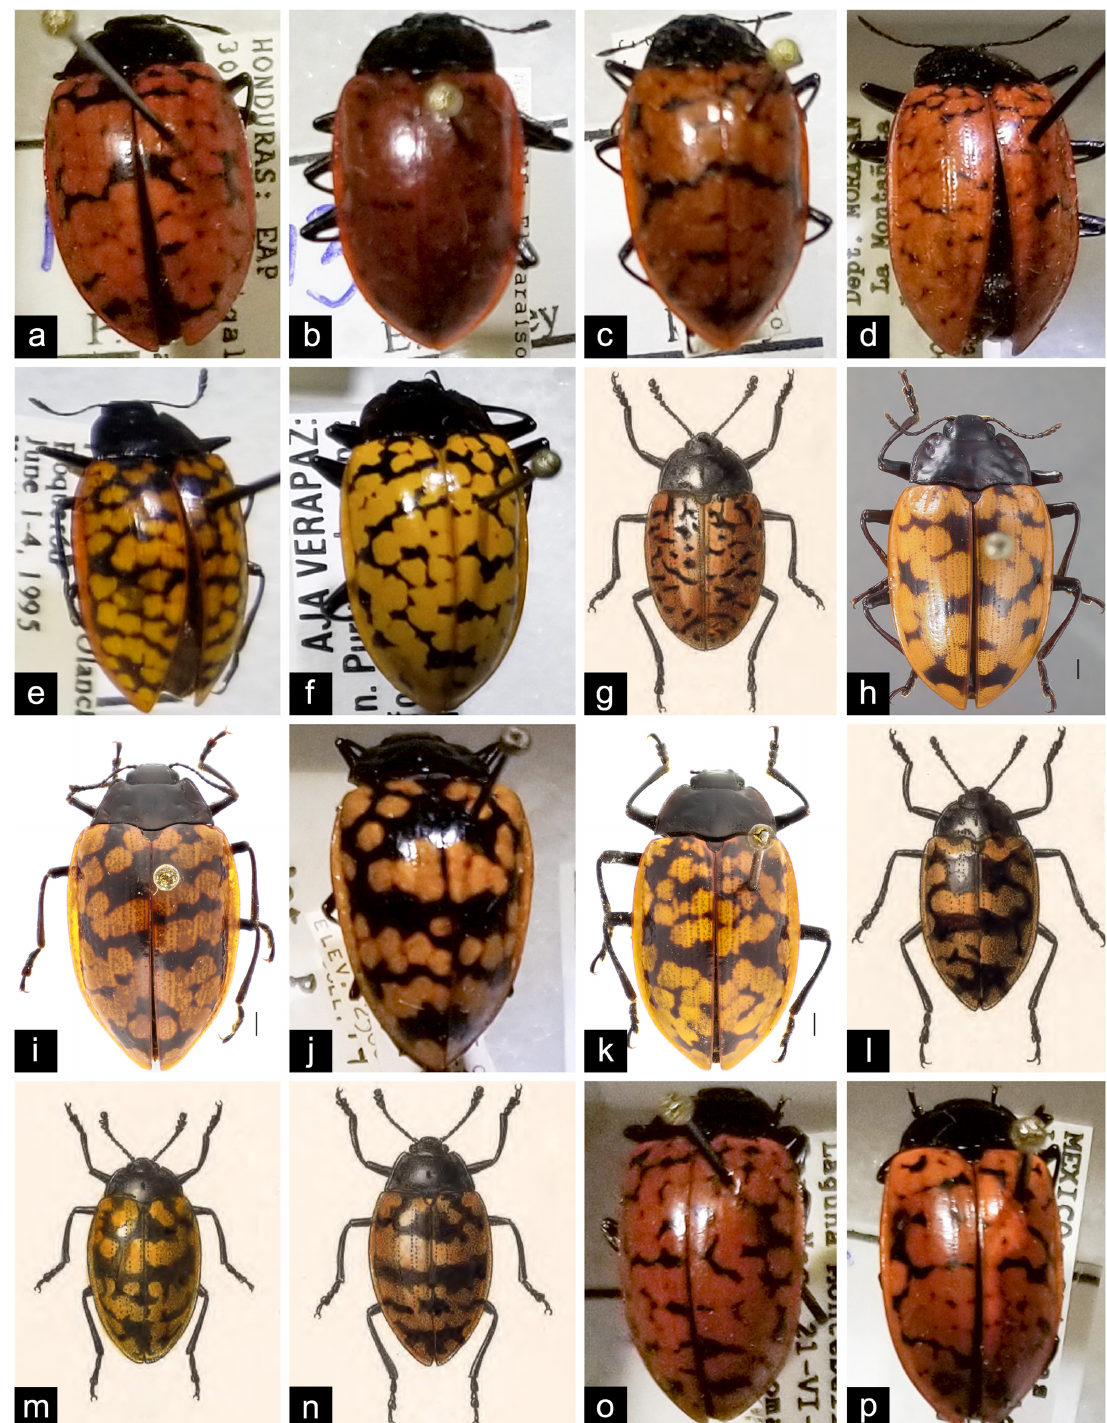
Figure 9. Erotylina leoparda (Lacordaire, 1842), specimens from different localities. Numbers in parentheses indicate localities listed in Table I. a–e. Specimens from Honduras (a–d, morph “ leoparda ”; e, morph “ nicaraguae ”): a (10), b–c (11), d (12), e (13). f–g. Specimens from Guatemala: f–g (19). h–p. Specimens from Mexico: h (20), i (21), j (22), k–n (23), o–p (26). g, i–n. Specimens illustrated in Biologia Centrali-Americana (Gorham 1888). Scale bars = h–i, k = 1